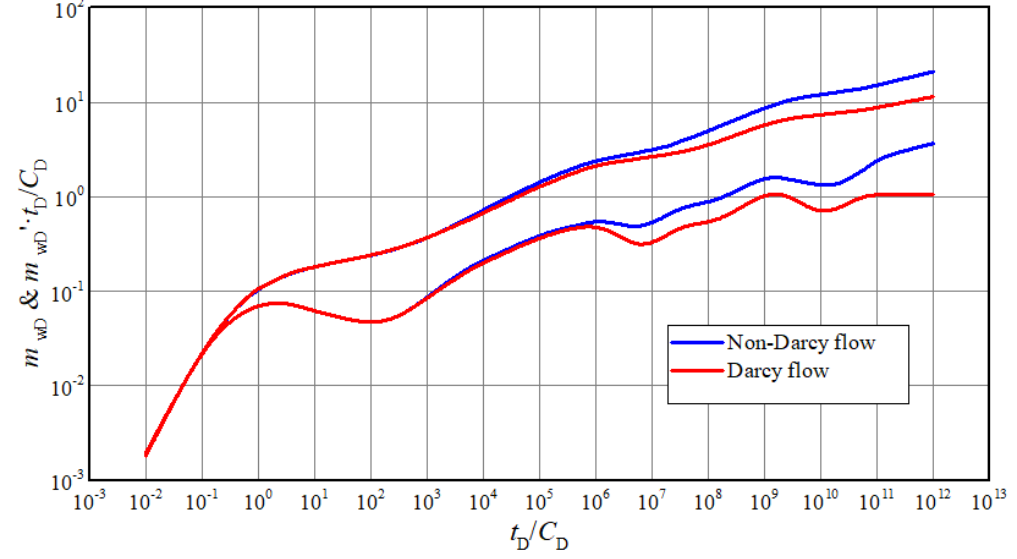
Figure 6. Comparison of typical curves between non-Darcy flow and Darcy flow.